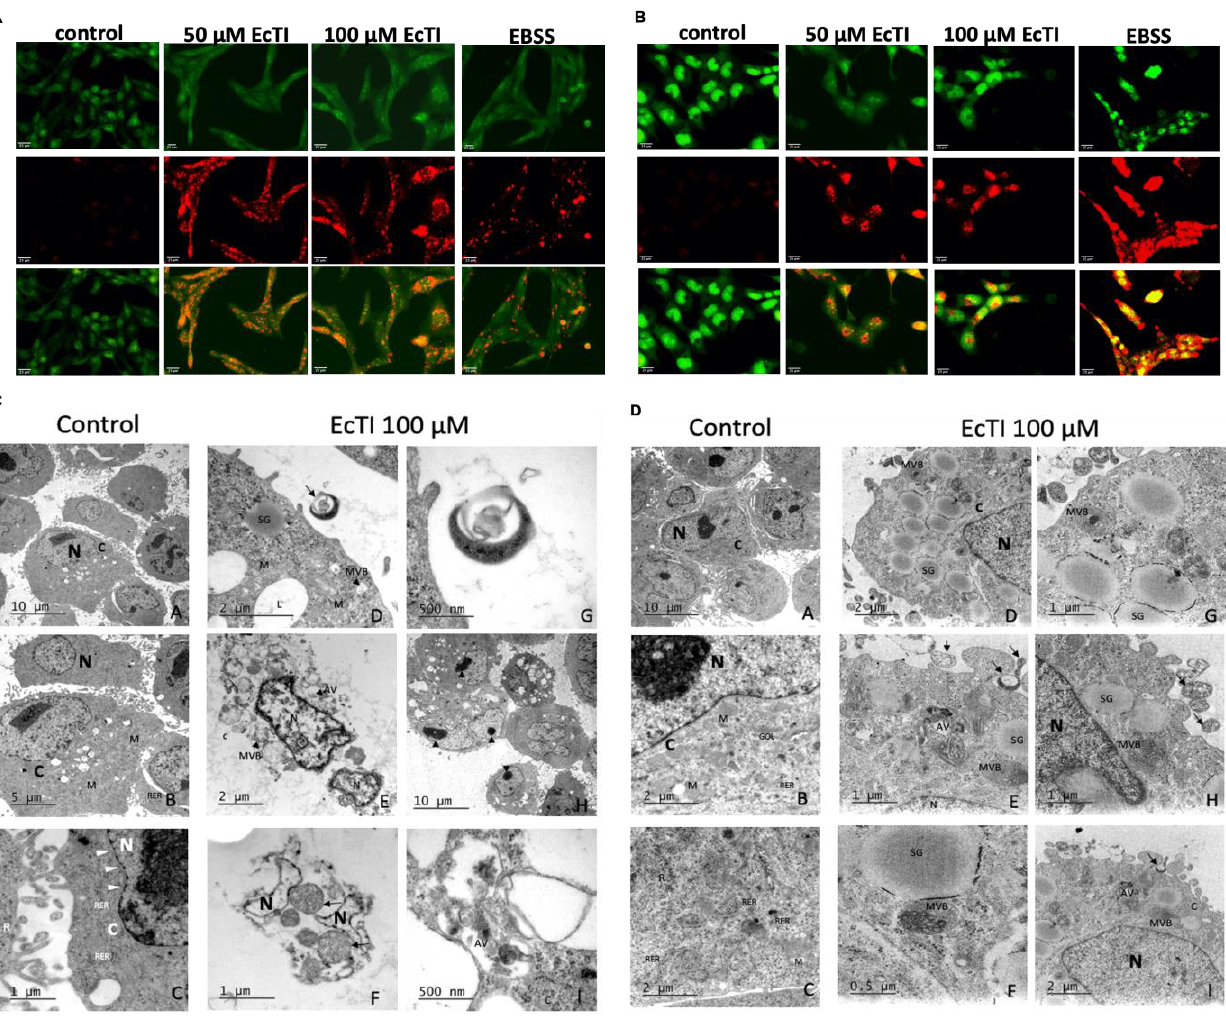
Figure 7. Acidic vesicular organelle formation and transmission electron microscopy. Cells were incubated with 50 and 100 µM EcTI for 24 h or EBSS medium for 3 h (positive control). After treatment, SK-MEL-28 ( A ) and CHL-1 ( B ) cells were stained with 0.5 μg/mL acridine orange (AO) for 15 min. EcTI intensified AO-stained red fluorescent-positive acidic vesicular organelles. The representative images, from three independent experiments, were observed under the same magnification, and the scale bar (25 μm) is presented in each. The impact of EcTI on SK-MEL-28 ( C ) cell morphology was analyzed through electron microscopy after 24 h of incubation; low magnification (10 µm) of control SK-MEL-28 cells (panel A ) exhibits a typical morphology. At higher magnification (5 µm and 1 µm), the presence of healthy mitochondria (M) , rough endoplasmic reticulum (RER) , free polyribosomes (R) , healthy cytoplasm (C) , nucleus (N) , and nuclear membrane (white arrowheads) in (panels